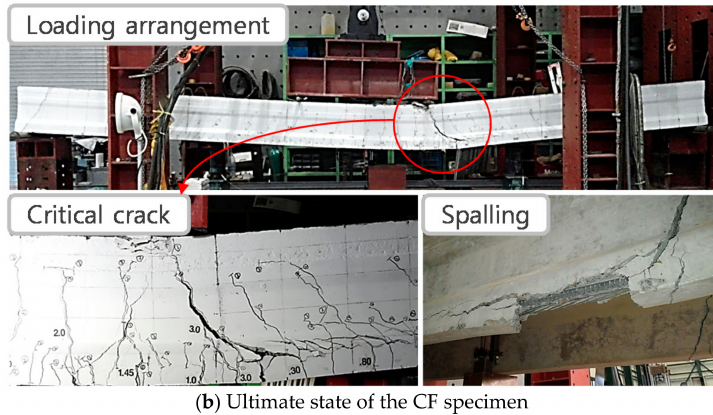
Figure 10. Failure crack patterns of the flexural specimens.